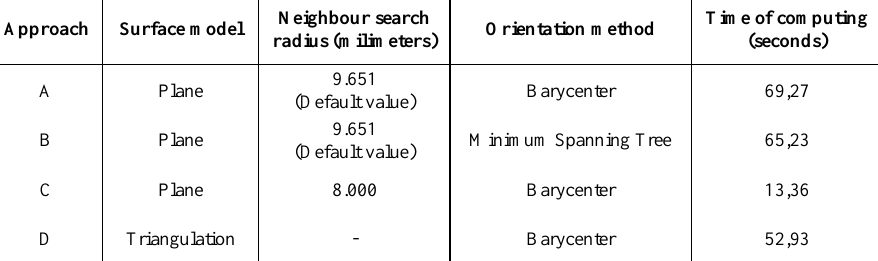
Table 2. Results of comparison of normal computing approaches. Part of North Gallery was chosen as test object (approx. 20 million